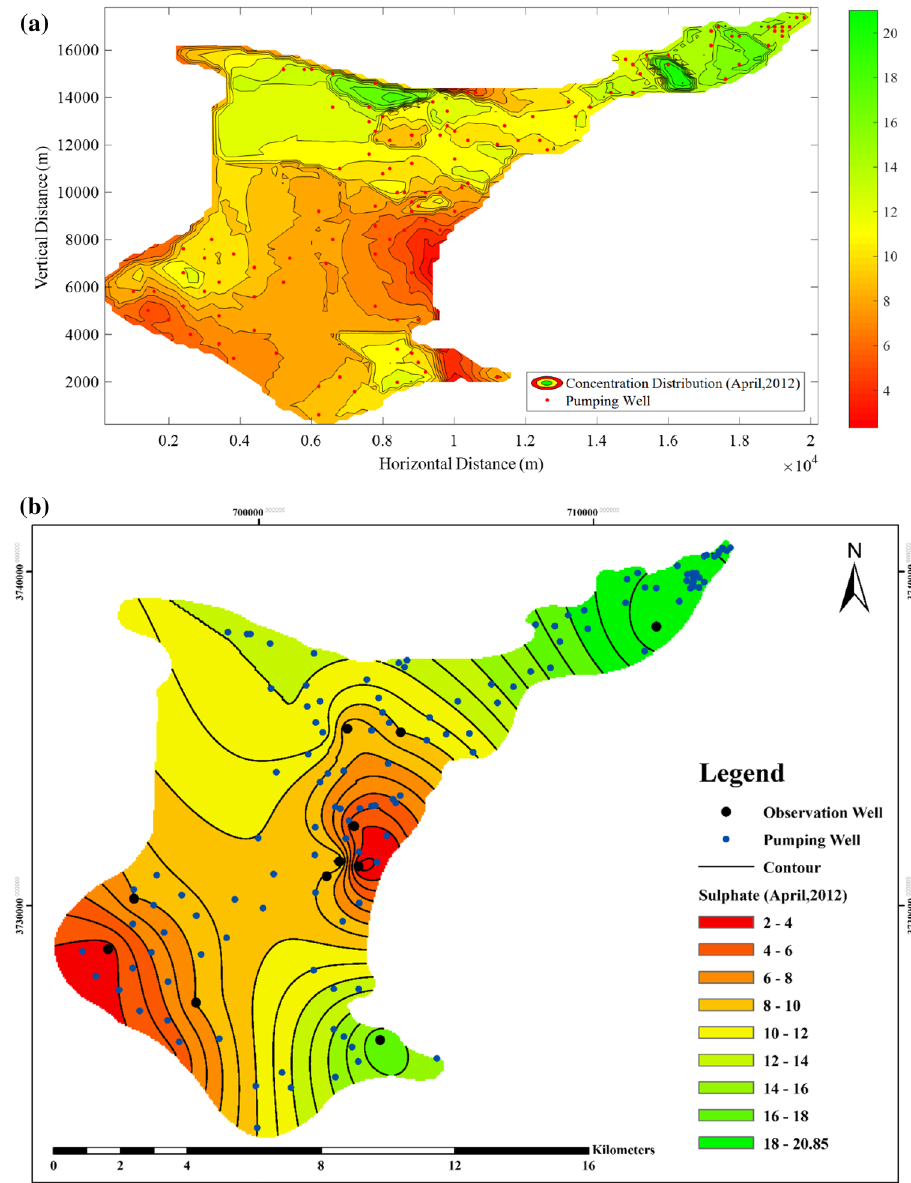
Fig. 13 Sulfate contamination contour lines (2012) a from the model b interpolated using